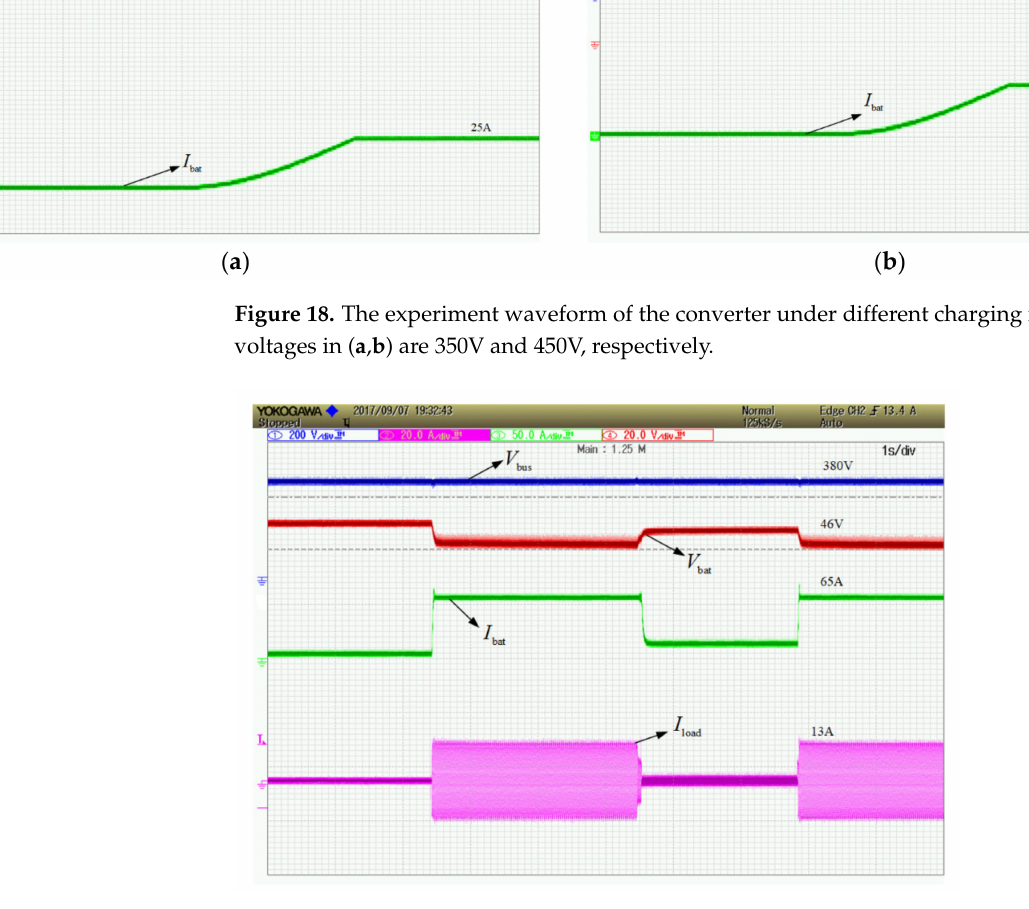
Figure 19. Experiment waveform of the converter under discharging